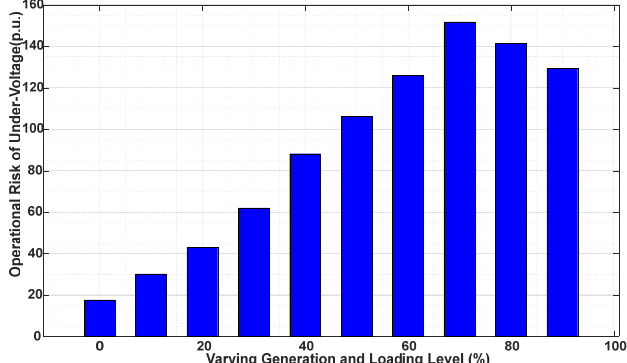
Figure 5. Operational risk of undervoltage as a function of GLL.